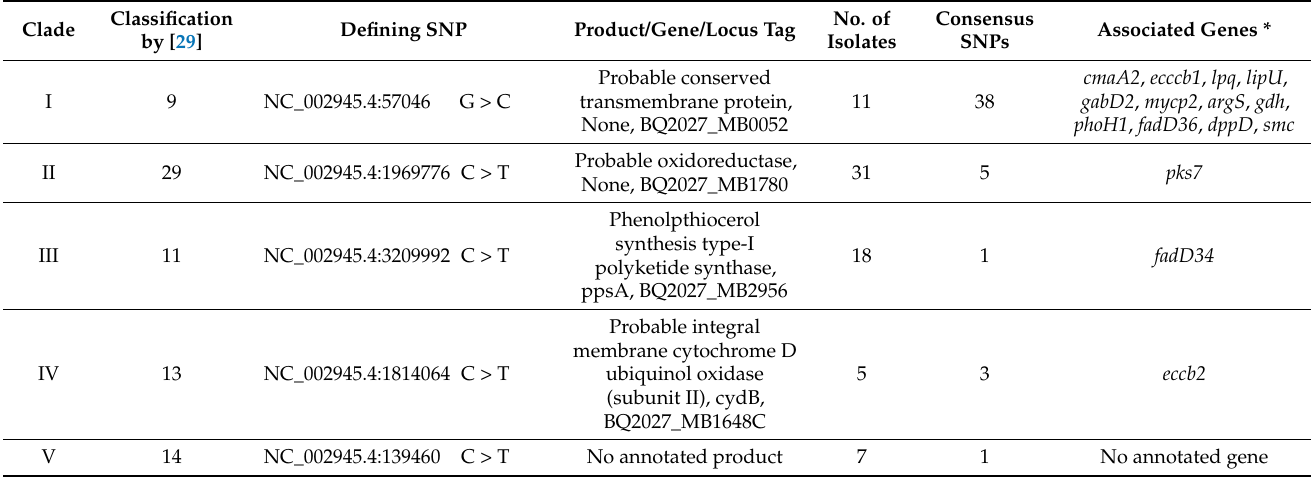
Table 2. Defining SNP characteristics for Catalonia M. bovis clades obtained through WGS and SNP analysis. Classification Clade by